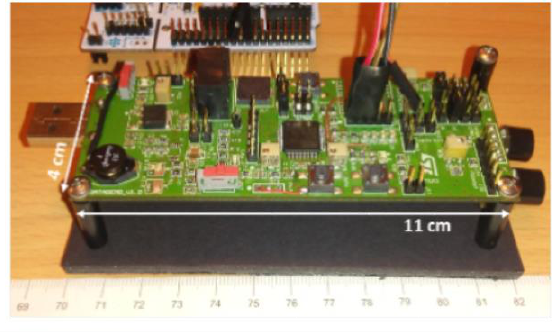
Figure 4. Ultrasound prototype module.